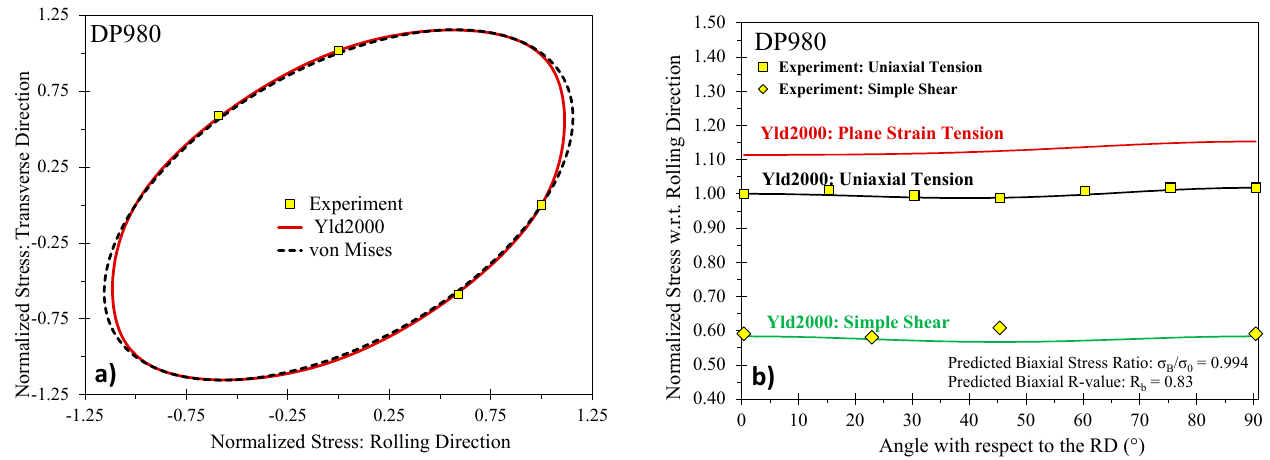
Figure 7. Calibrated Barlat Yld2000 yield surface for the 590R ( a ) and predicted stress ratios ( b ).